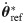
Consistent θ˙ref* for varying initial distance from impact point D0 = a0 − R and varying initial ball velocity ν while keeping φ=π4 fixed.Values greater 1 are clipped. Different values for φ only moderately scale the value of θ˙ref* (see Eq 27).